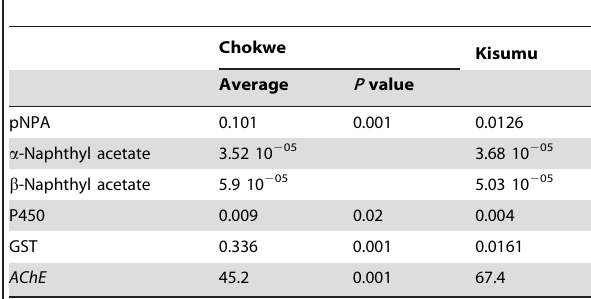
Table 2. Comparisons of average values for a range of biochemical assays between F 1 adult progeny An. funestus from Tihuquine populations and the An. gambiae Kisumu insecticide-susceptible reference